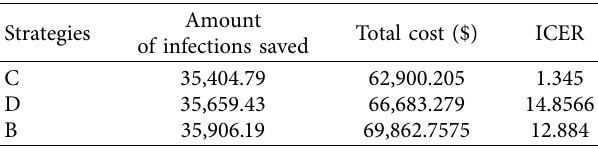
Table 7: Amount of the total infection averted and total cost used with ICER.